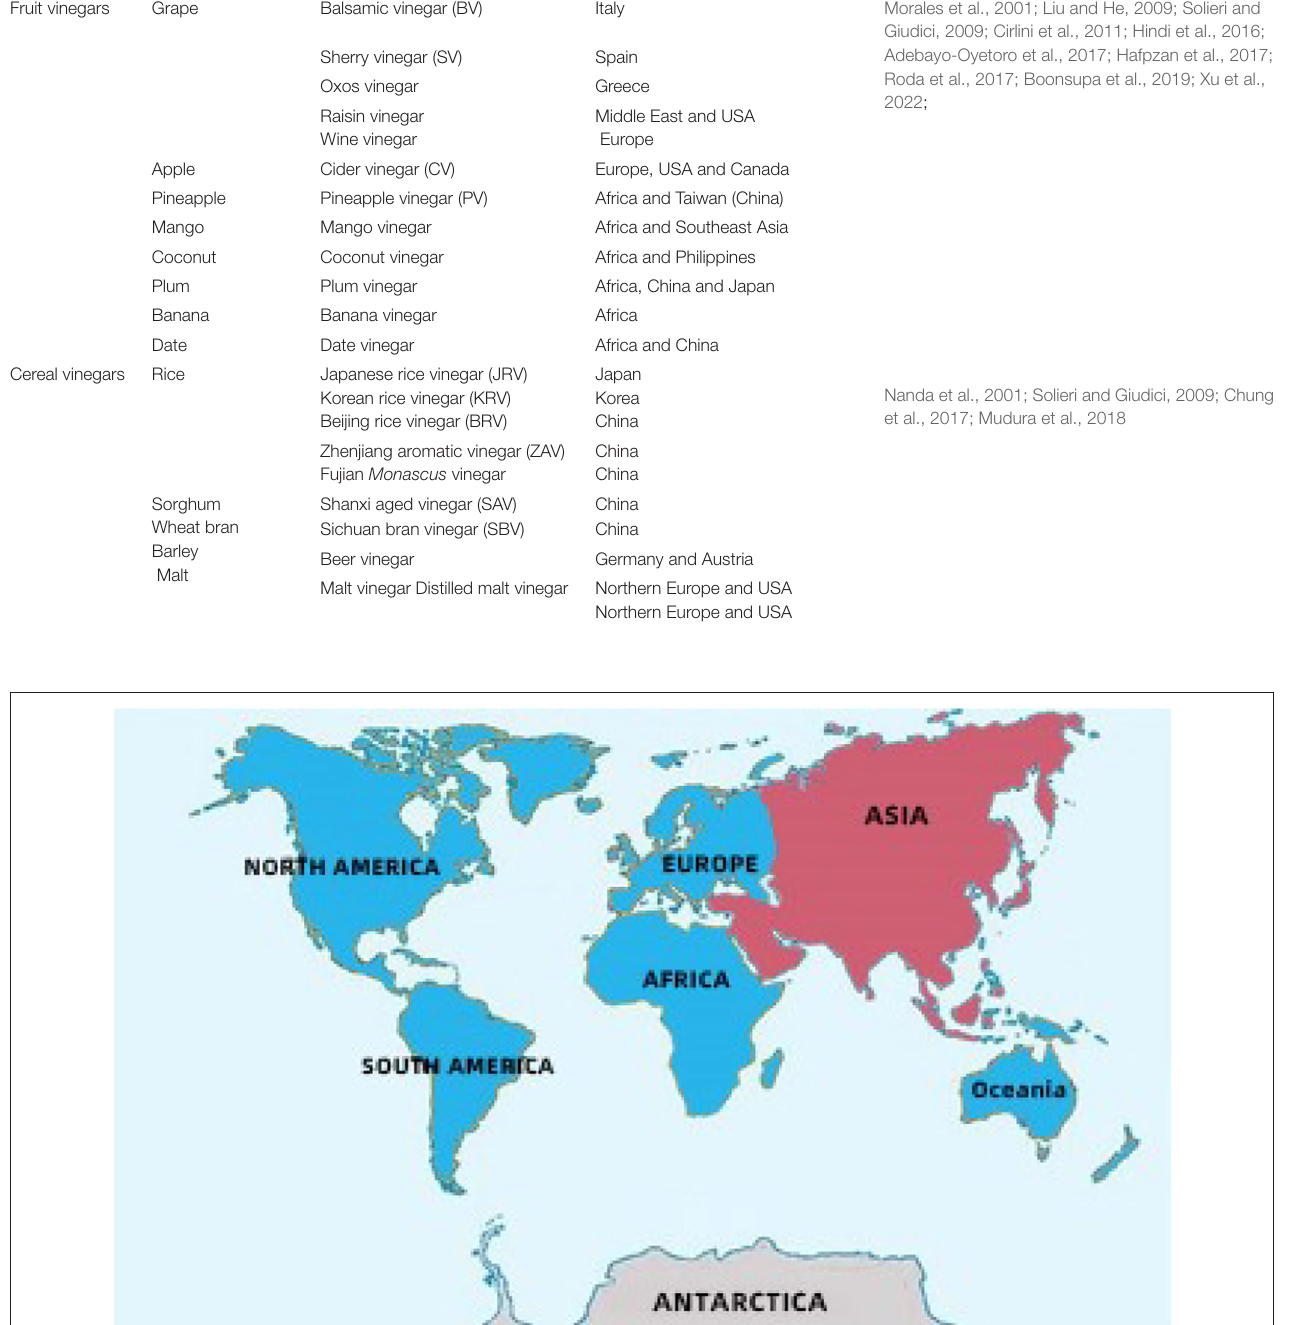
produce the fruit vinegar (Chang et al., 2005). There are numerous famous traditional fruit vinegars in the world, such